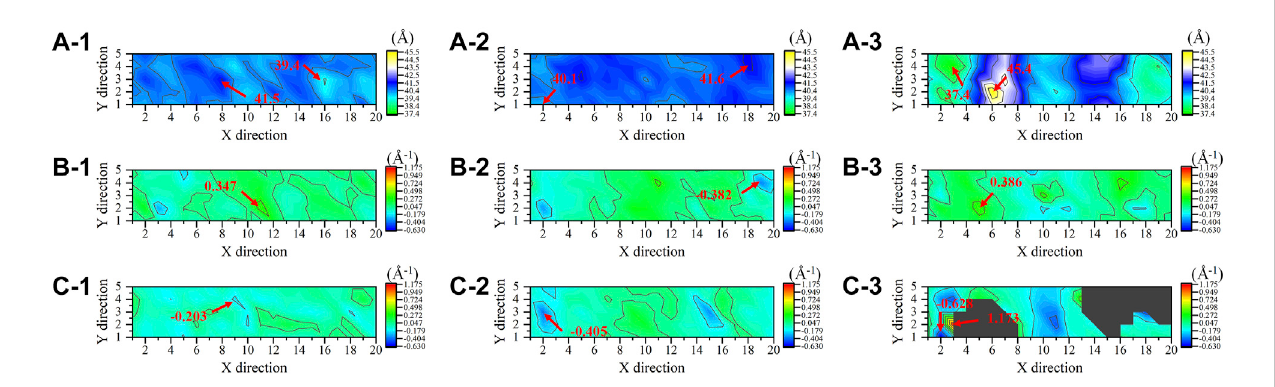
FIGURE 9 Thedistancesbetweenthephosphategroupsinthelowerandupperlayers (A) ,themeancurvatureoflowerlayers (B) andupperlayers (C) inlipidsystem (1), lipid-peptide system (2) and lipid-PEG-peptide system (3).